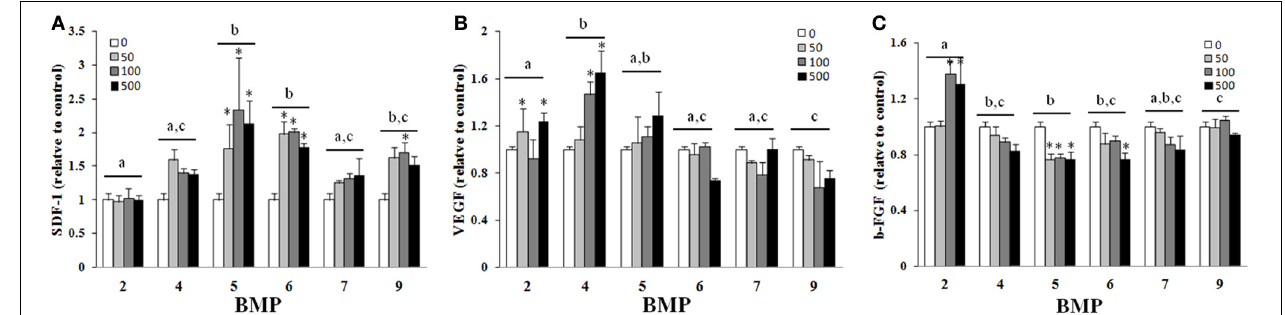
presented as relative to control. Different letters signify a difference among groups, p ≤ 0 . 05. Error bars are ± SEM. Different letters signify a